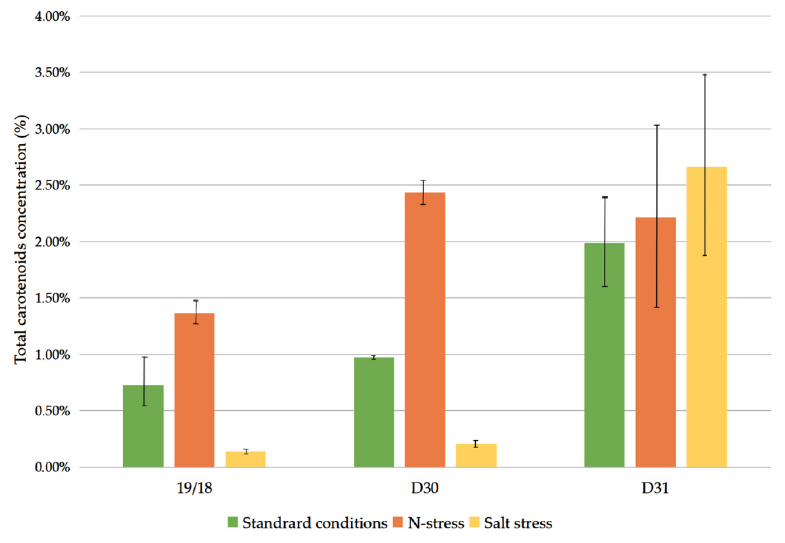
Figure 6. Total carotenoid content of the Dunaliella salina CCAP 19/18, AthU-Al D30 (D30) and AthU-Al D31 (D31) strains cultivated in standard conditions, under nitrogen deprivation (N-stress) and under high salinity (salt stress), expressed as % of total biomass. [STDEV, n = 3].